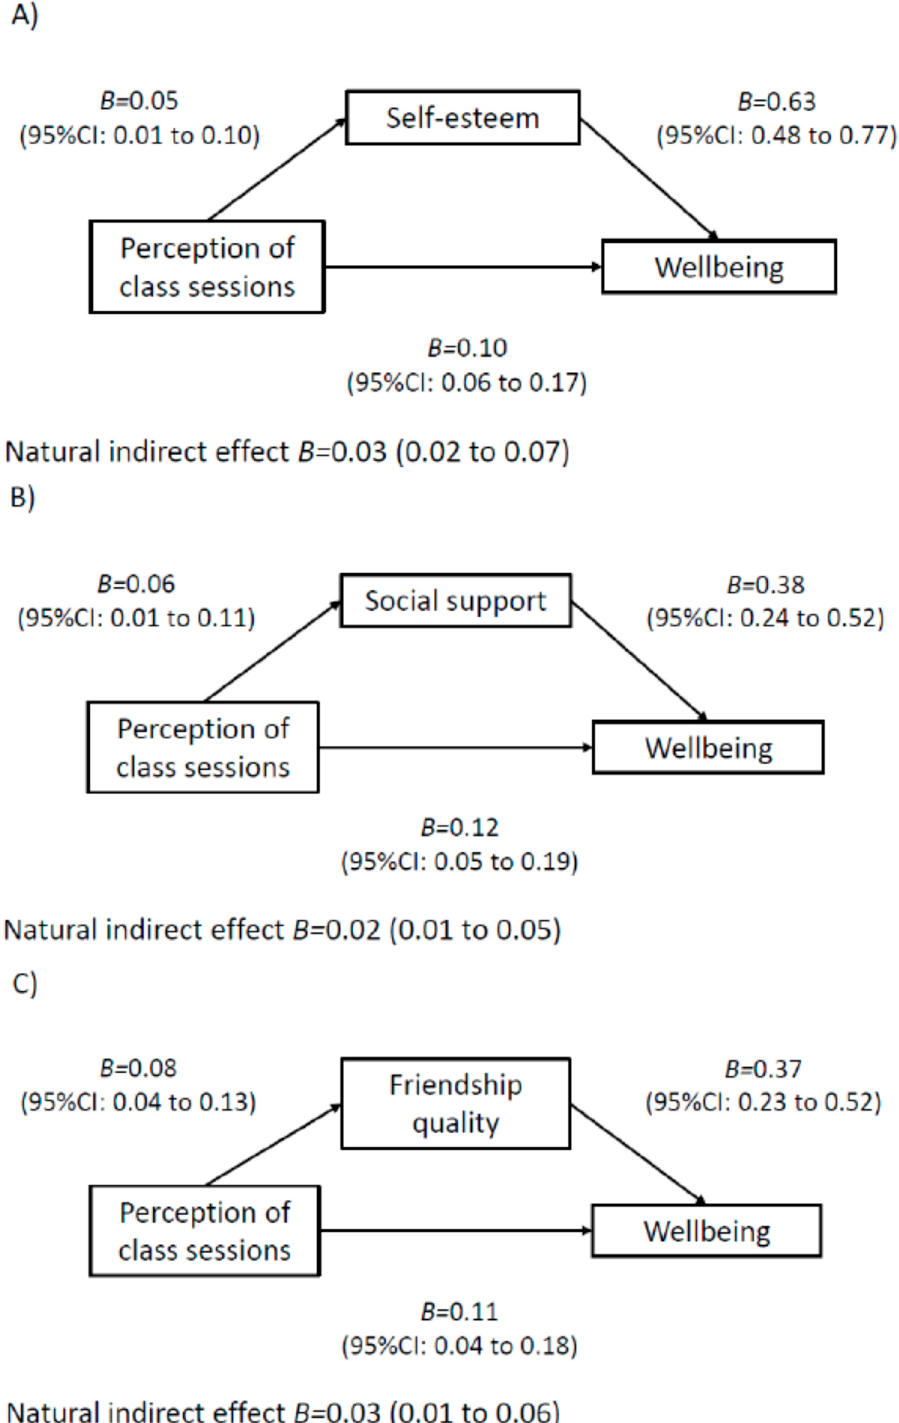
Figure 2. Mediation models of potential psychological mediators in the association between intervention components and wellbeing among boys. Note. Adjusted for age, ethnicity, language, school, body mass index and baseline values of change variables. CI, confidence interval. E-values estimates (in relative risk): Model A : E-value: 1.34, Model B : E-value: 1.29, Model C : E-value: 1.25